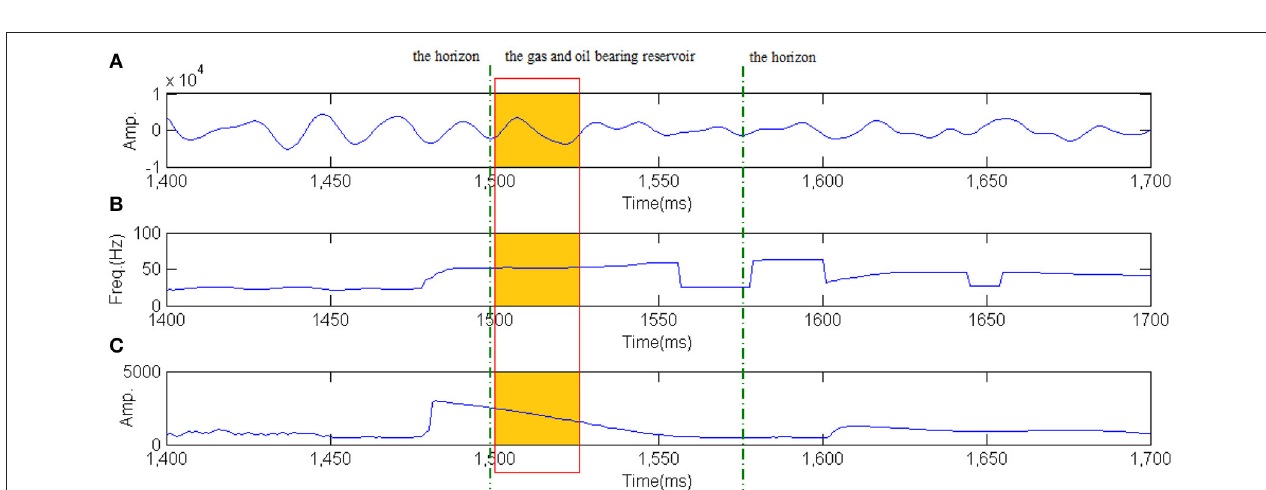
FIGURE 8 | the IFs of the first two IMFs extracted by the wavelet ridge and HT respectively. (A) The IF of the IMF1. (B) The IF of the IMF2.